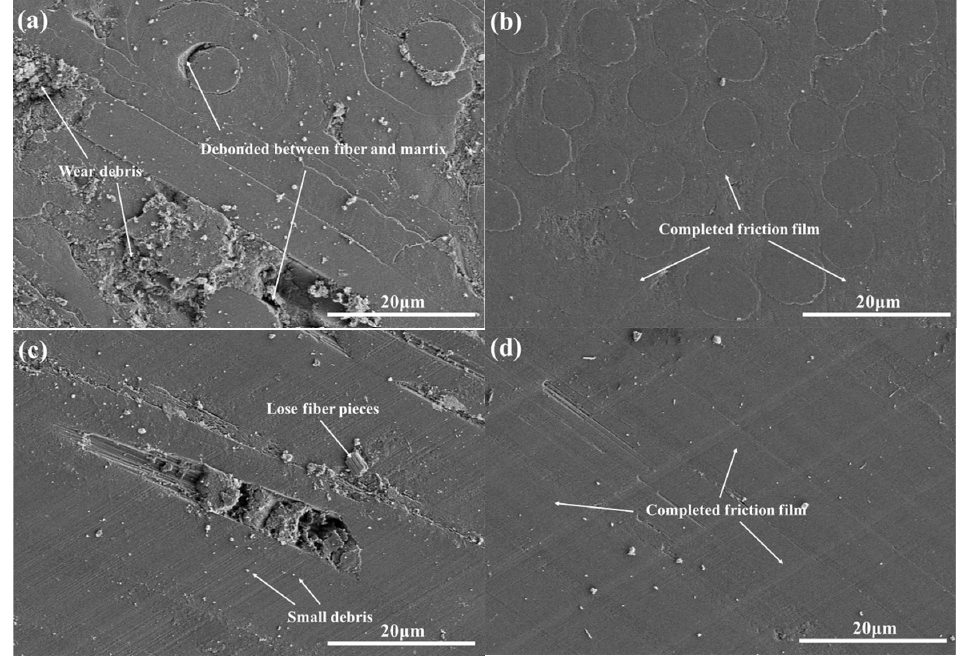
Figure 14. SEM morphologies of the worn surfaces of both composites: ( a ) C/C NL; ( b ) C/G/C NL; ( c ) C/C RTO; and ( d ) C/G/C RTO.